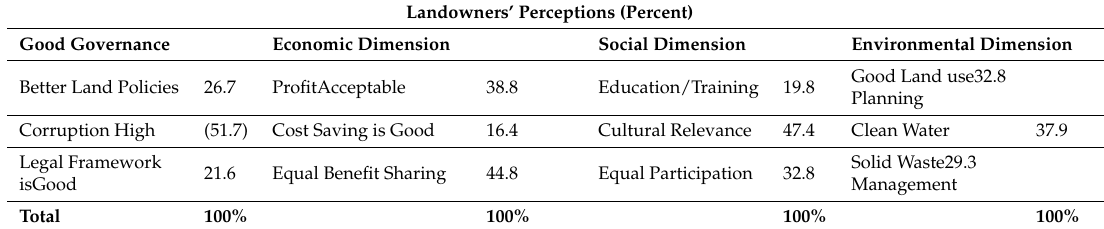
Table 4. Indicators of ILG Sustainability: Perceptions of landowners who thought that each indicator (parameter) was the most